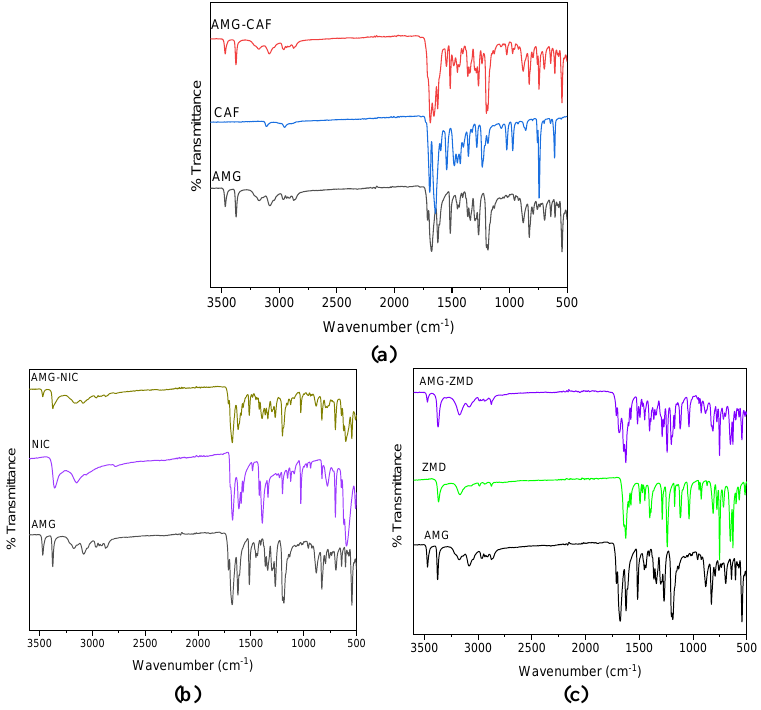
Figure 4. Comparison of FT-IR spectra of starting materials AMG and coformer with their respective eutectic composition for ( a ) AMG and CAF, ( b ) AMG and NIC, and ( c ) AMG and ZMD.